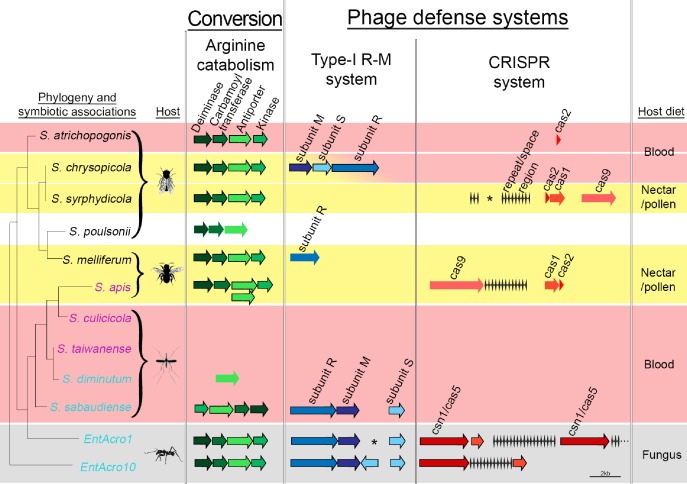
Organization of the arginine catabolism operon and two groups of bacteriophage-defense related genes (Type-I R-M and CRISPR systems) in EntAcro1 and EntAcro10 and closely related Spiroplasma symbionts of other insect hosts.The tree on the left and the color-coded species names specify different types of association (as in Figure 1 with pink representing confirmed pathogenicity, light blue representing confirmed non-pathogenicity, and black indicating unknown but likely non-pathogenic; Supplementary file 4). Background colors highlight specialized host diets: fungus (gray), blood (red), nectar/pollen (yellow; mixed in deerflies hosting S. chrysopicola where males feed on nectar/pollen and females on blood) and unclear (white; food of Drosophila host is unknown but unlikely to be a specialized diet). Genes in each pathway have different shades of a single color and sizes of arrows and spaces between them are proportional to actual gene sizes relative to the 2 kb scale bar (bottom right). Gene orientations correspond to the direction of arrowheads and all genes are presented with their common names as identified by our RAST annotations (Supplementary file 3). Gene-arrows have a black outline when all core genes for a focal pathway are present, indicating it is functionally active. The asterisks for the Type-I R-M system in EntAcro1 and the CRISPR system in the symbiont of S. syrphydicola indicate that the gap between the two arrows is not proportional to the scale bar but much wider.